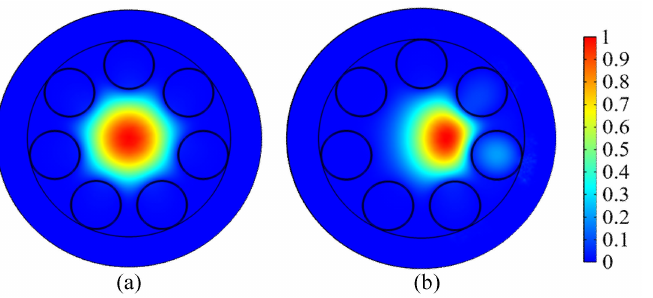
Figure 3. Normalized optical field distributions of the fundamental mode of the designed HCF: ( a ) straight fiber; ( b ) curved fiber with the bending radius of 100 mm.